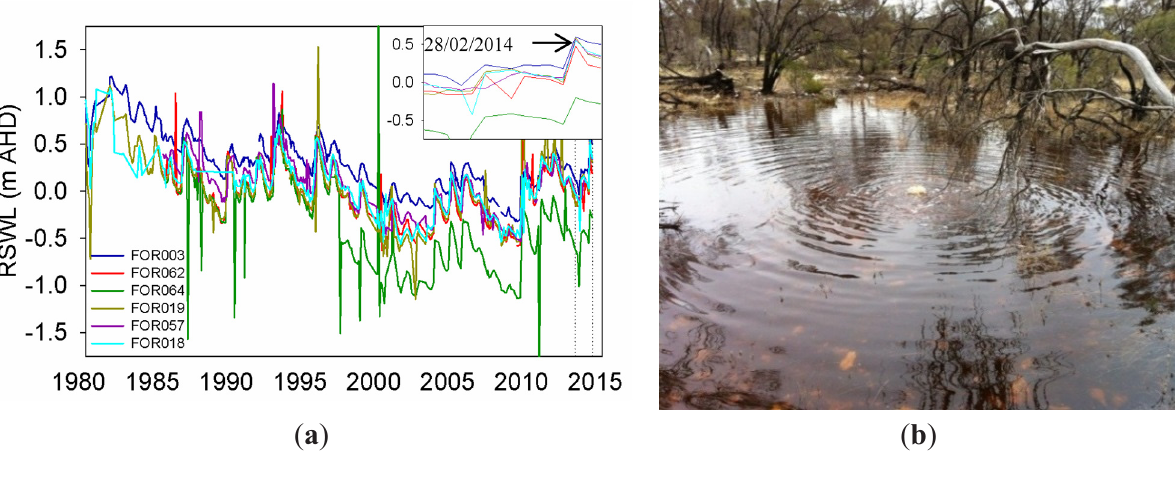
Figure 9. Reduced Standing Water Level (RSWL) fluctuations in the Robinson lens ( a ) selected hydrographs with inset from March 2013 to May 2015 ( b ) Air escaping through a fissure in calcrete (macropore) during rapid